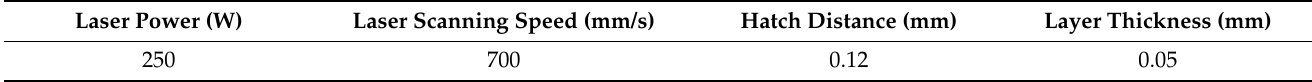
Table 4. Parameters applied for SLM fabrication.